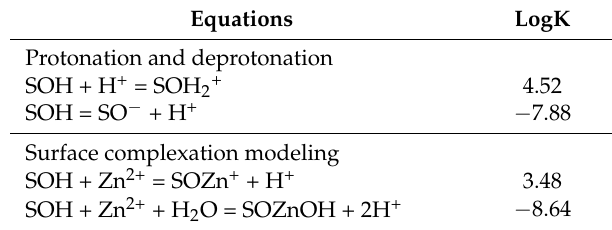
Table 4. Theoptimized parameters of surface complexation modeling for Zn(II) adsorption on GO.